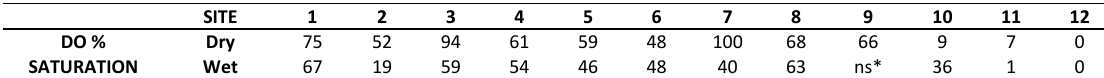
Table 3: The results show DO percentage saturation in dry and wet seasons